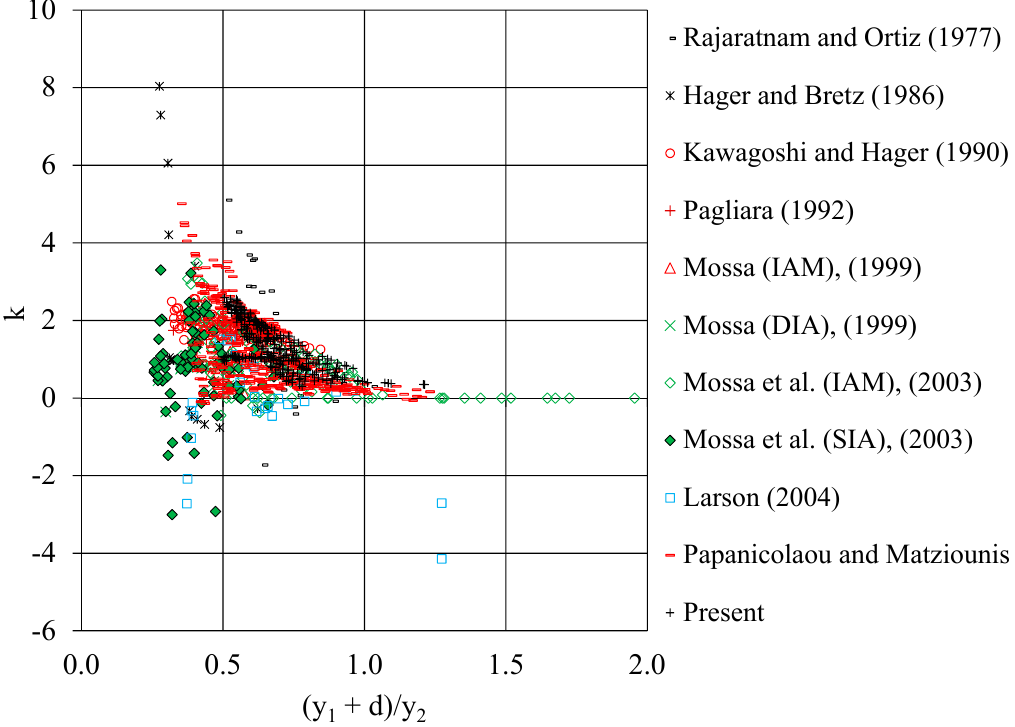
Figure 17. Comparison of k versus (y 1 + d)/y 2 , from the present and earlier investigations [4,6,7,9,12,13,19,22,23]. Table 4. Main geometric and hydraulic parameters of earlier and the present experiment.